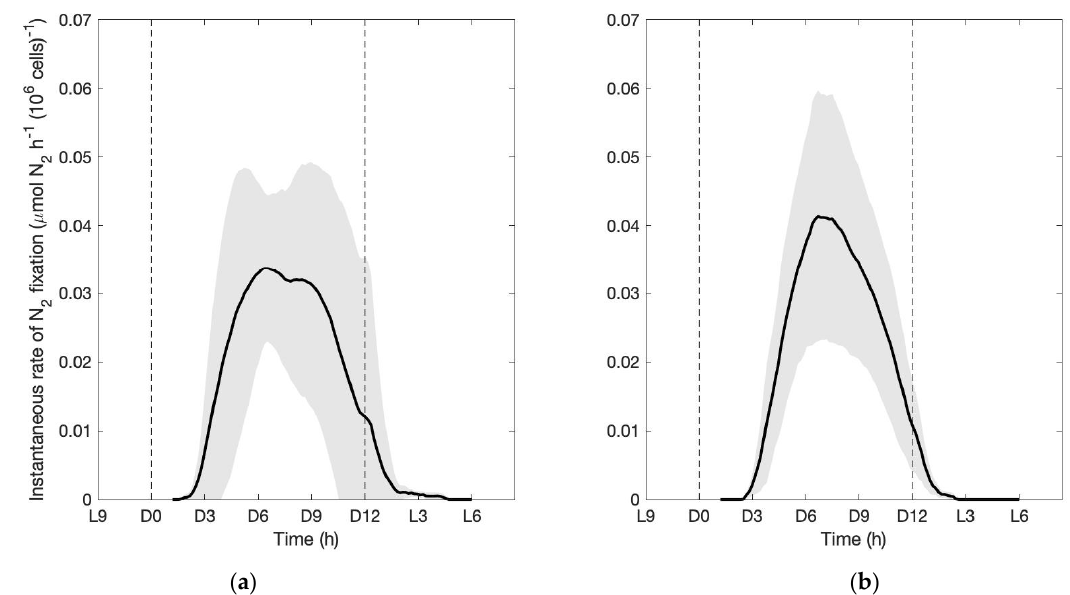
Figure 3. Experiment 3-1. Nitrogenase activity in ( a ) the NO 3 − -rich cultures and ( b ) the NO 3 − -free cultures. The average, real-time N 2 fixation rate recorded on the cultures (black line), expressed in μ mol N 2 fixed per hour and per million cells, is shown with its standard deviation (grey shaded area). Vertical dashed lines indicate the onset of the dark (at D0) and onset of the light (after 12 h of dark, at D12 = L0).